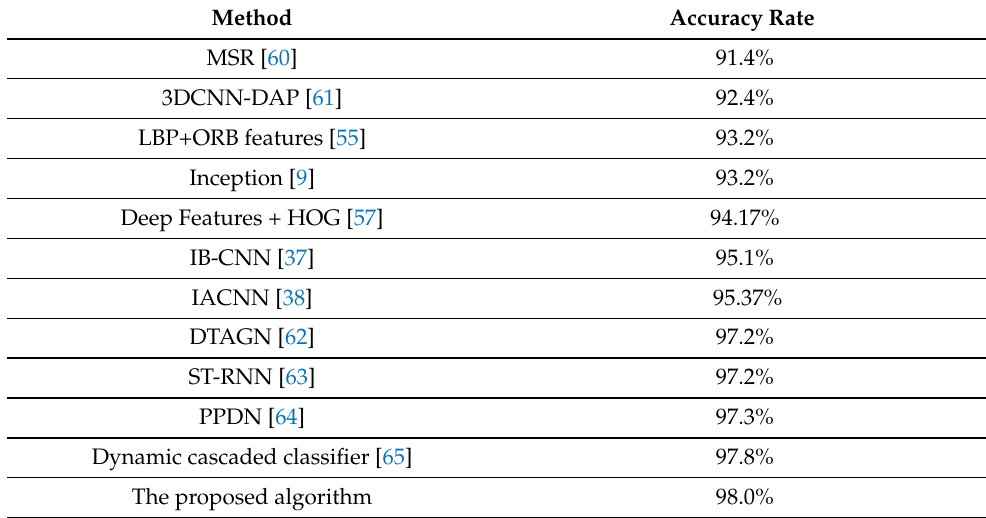
Table 4. Classification accuracy on